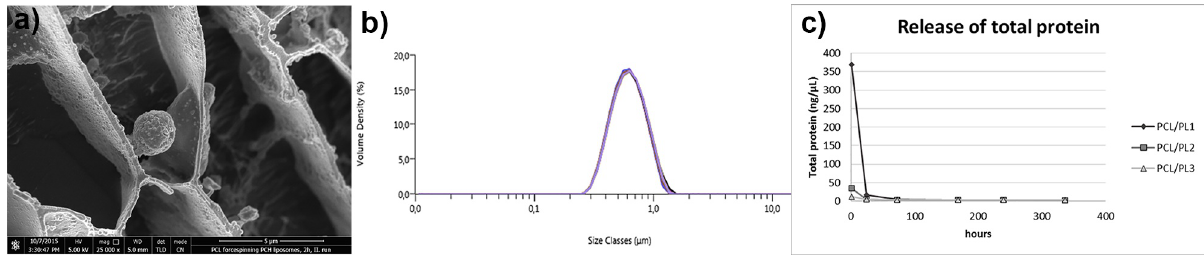
Figure 1. Cryo-scanning electron microscopy of fibers prepared by centrifugal spinning techniques with adhered liposomes. Detection of liposomes size distribution using dynamic light scattering (b) and detection of overall protein release (c).